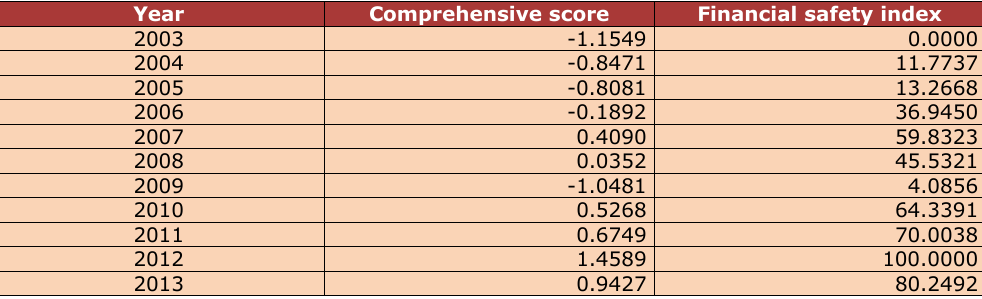
Figure 3 indicates the change trend of financial safety indexes from 2003 to 2013